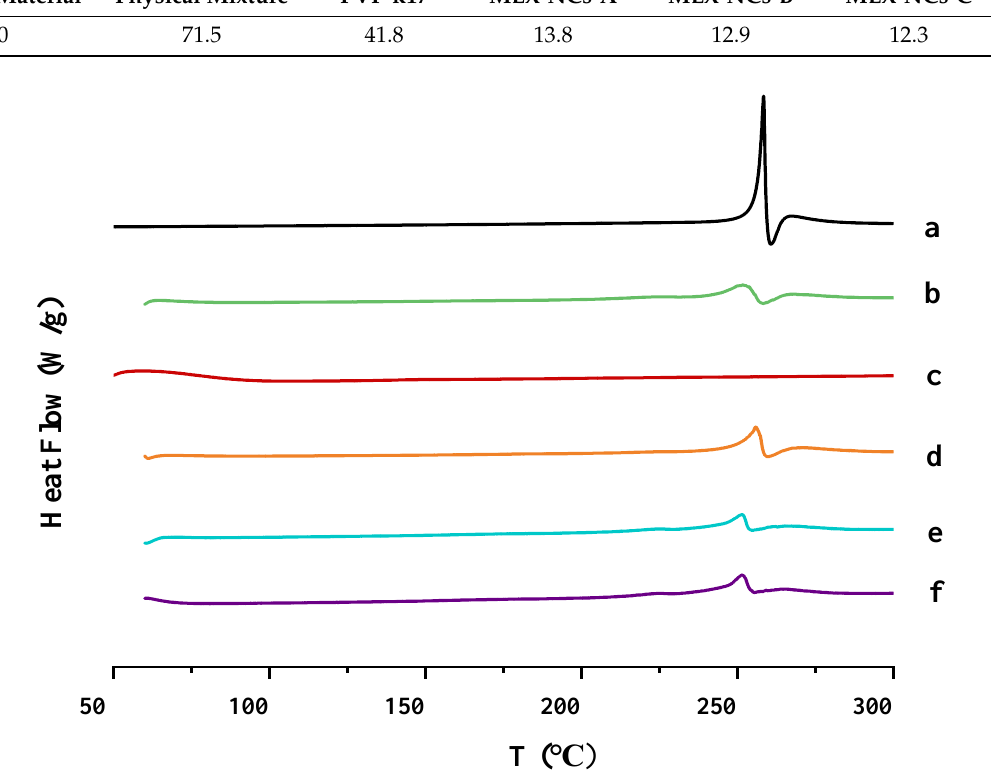
Figure 7. Differential scanning calorimetry graphs (DSC). ( a ) Pure MLX material; ( b ) physical mixture; ( c ) PVP-k17; ( d ) MLX-NCs-A; ( e ) MLX-NCs-B; and ( f ) MLX-NCs-C. Table 1. The enthalpy values in the DSC transitions.